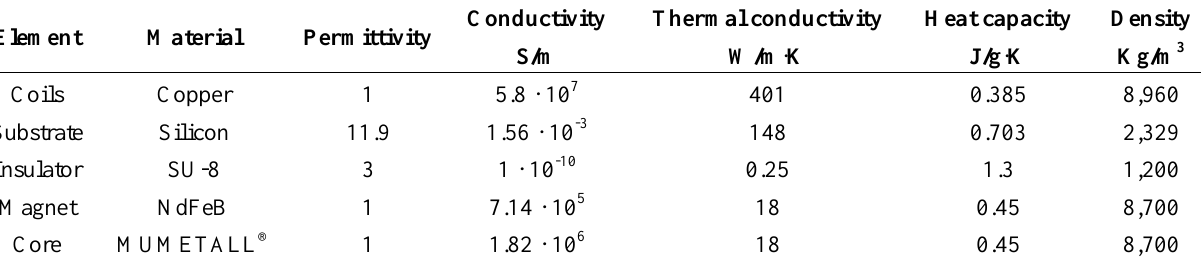
Table 1. Material properties of the sensor.